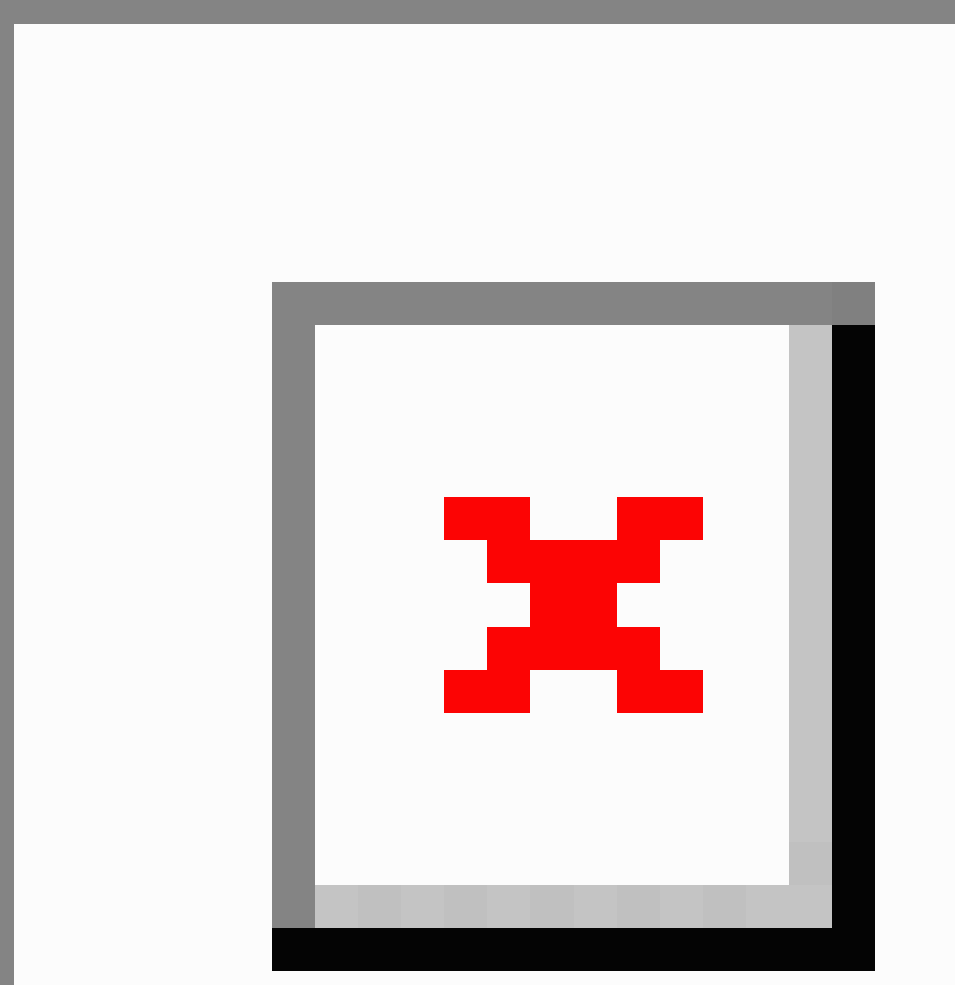
Figure 5. Attitude toward the physician as a function of review style and number of